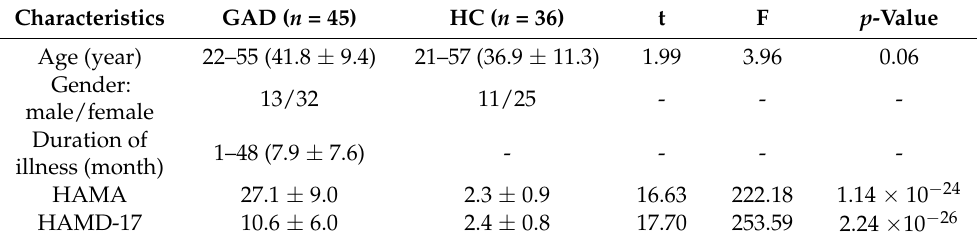
Table 1. Demographic and clinical characteristics of the